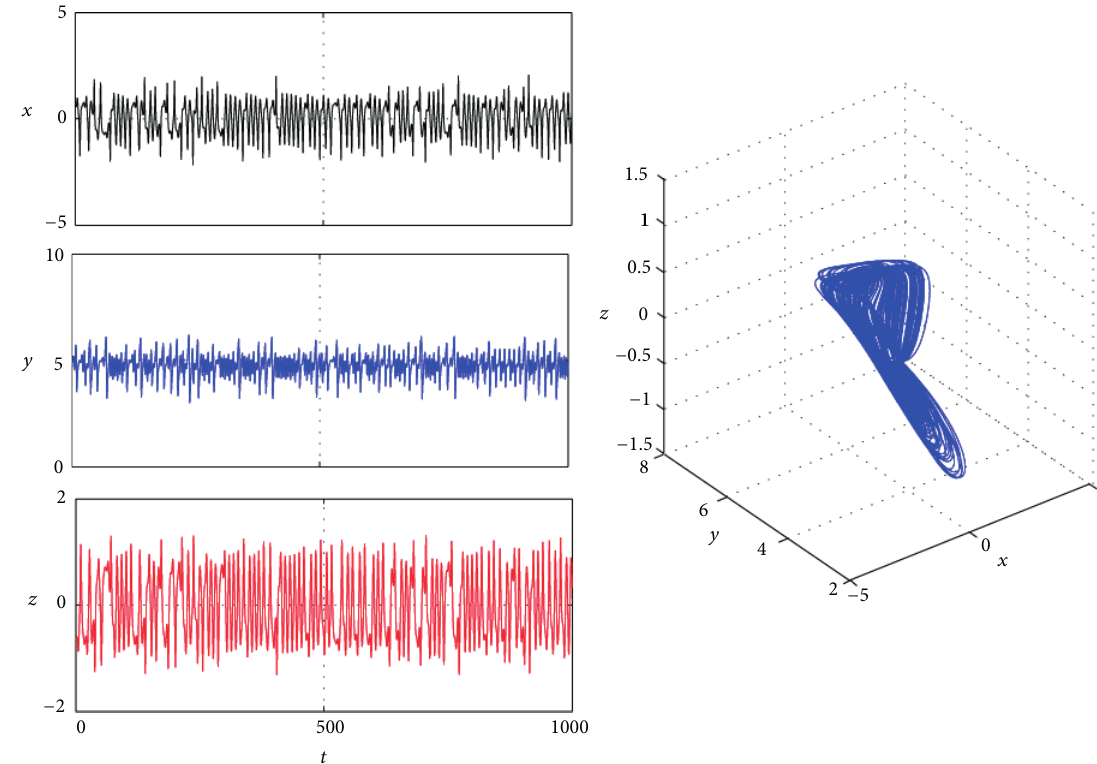
Figure 1: Trajectories 𝑥(𝑡) , 𝑦(𝑡) , and 𝑧(𝑡) and phase graphs of system (1) with 𝑎 = 4 , 𝑏 = 0.1 , and 𝑐 = 1 .